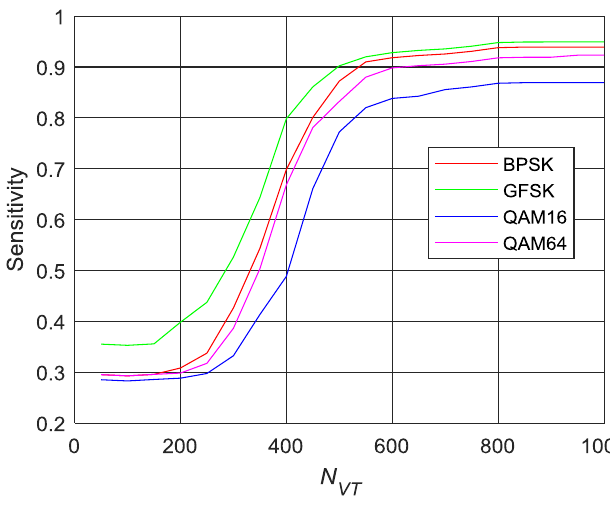
Figure 12. Sensitivity curves for BPSK, GFSK, QAM16, and QAM64 with AMR at SNR = 5 dB.